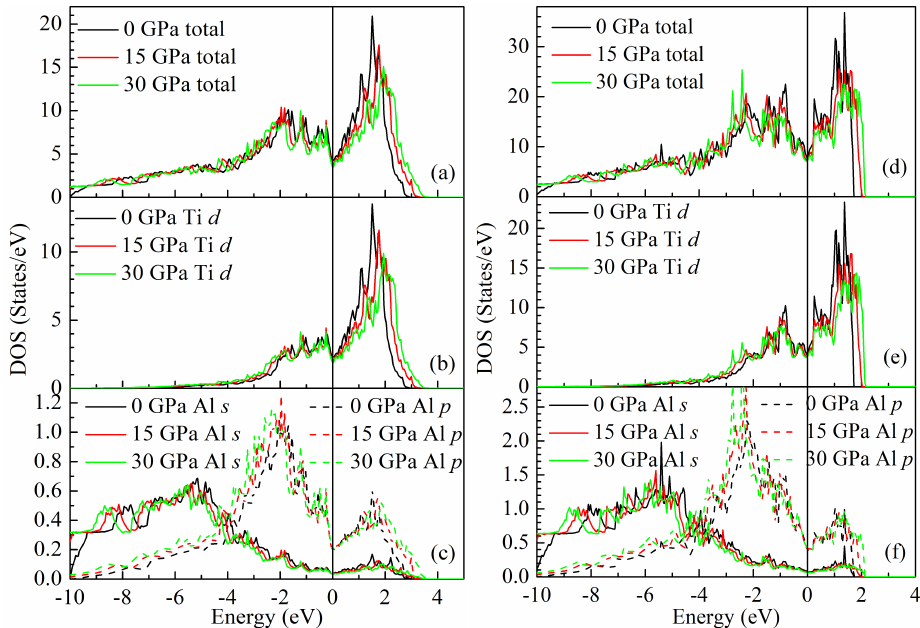
Figure 13. Calculated total and partial densities of states (DOSs) for the LPS h- and r-Al 2 Ti at the pressures of 0, 15 and 30 GPa and the temperature of 0 K: ( a , d) for total DOS, ( b , e ) for the DOS of Ti d orbital, ( c , f ) for the DOSs of Al s and p orbitals. The Fermi level is shift to 0